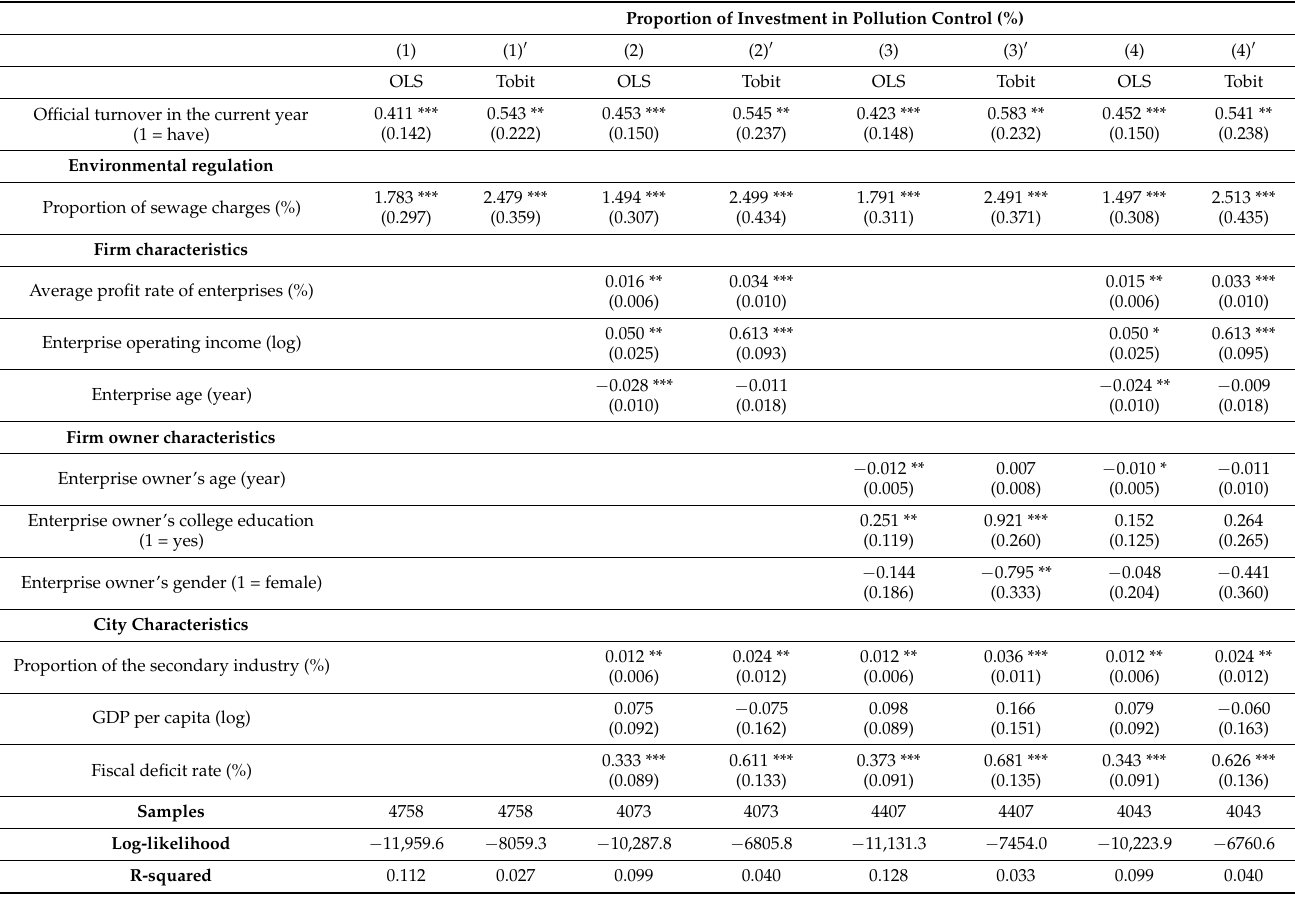
Table 2. The effect of municipal party secretary turnover on private enterprise pollution control investment: benchmark